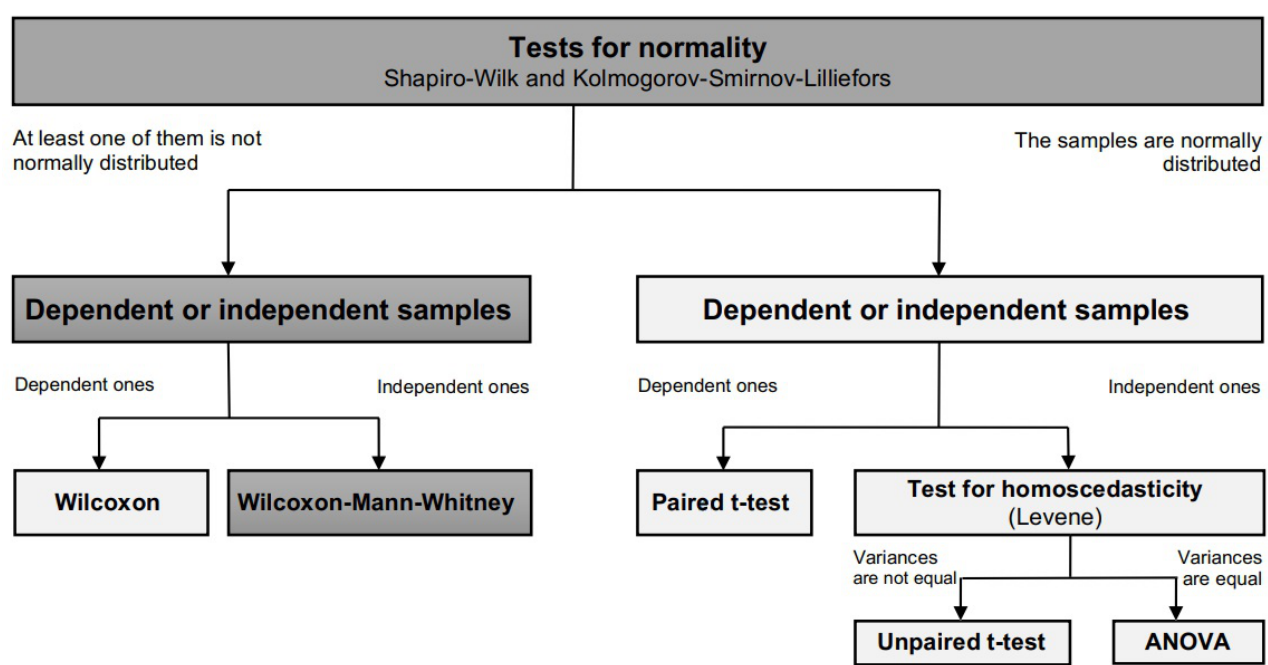
Figure 3. Statistical